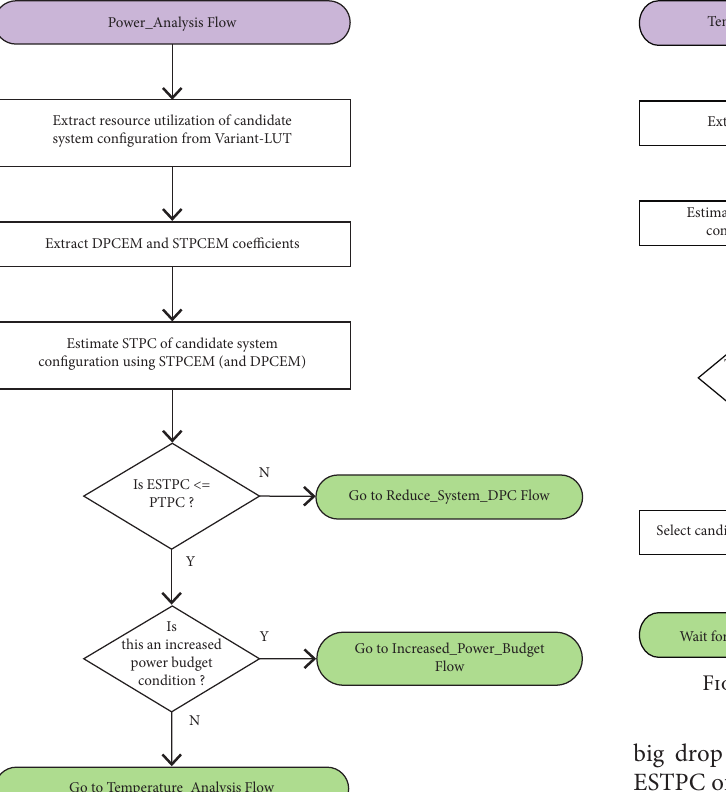
Figure 6: Power_Analysis flow of Explorer.